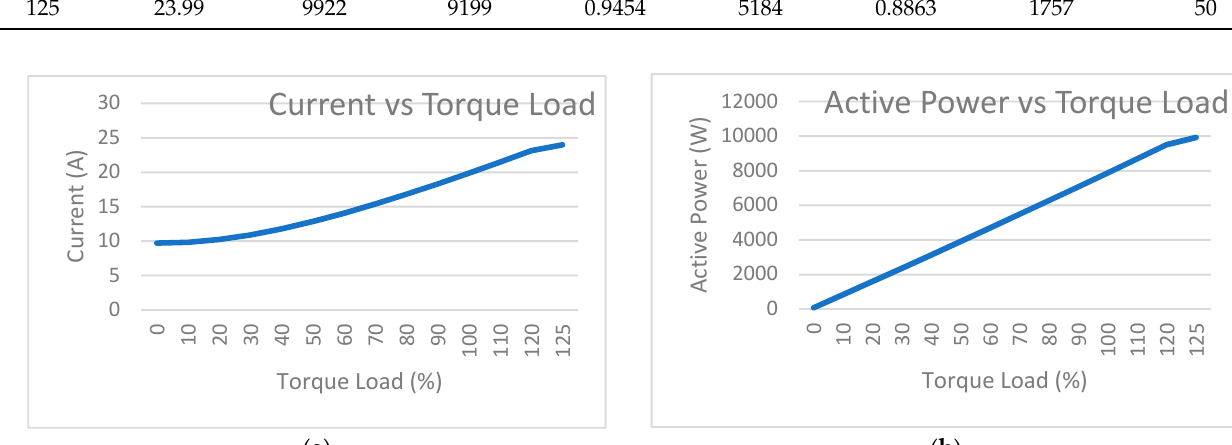
Figure 13. ( a ) Current vs torque load; ( b ) active power vs torque load.